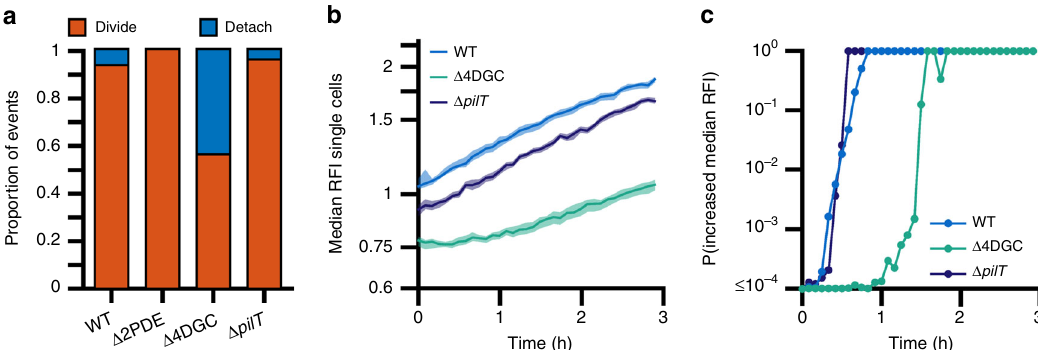
Fig. 6 Heightened levels of MSHA retraction increases detachment from the surface, and loss of pilT decreases c-di-GMP levels in surface-attached cells. a Proportion of cells that either divide on the surface or detach from the surface. The total number of cells analyzed per strain was; WT n = 512, Δ 2PDE n = 65, Δ 4DGC n = 145, Δ pilT n = 45. The proportions are statistically signi fi cantly different among the strains according to the χ 2 test p ≤ 0.0001. b Measurement of c-di-GMP levels in single cells inside a fl ow cell using the biosensor. Lines indicate the median RFI values per time point, and the shaded areas represent the 95% con fi dence intervals obtained from the bootstrap sampling distribution of the median RFI values. Time 0 h corresponds roughly to when cells initially encounter the surface of the fl ow cell. c Plot of the probability of c-di-GMP increase, calculated by comparing the bootstrap sampling distributions of the median RFI values between every time point ( I t ) and the fi rst ( I 1 ). C-di-GMP is determined to be increasing if I t / I 1